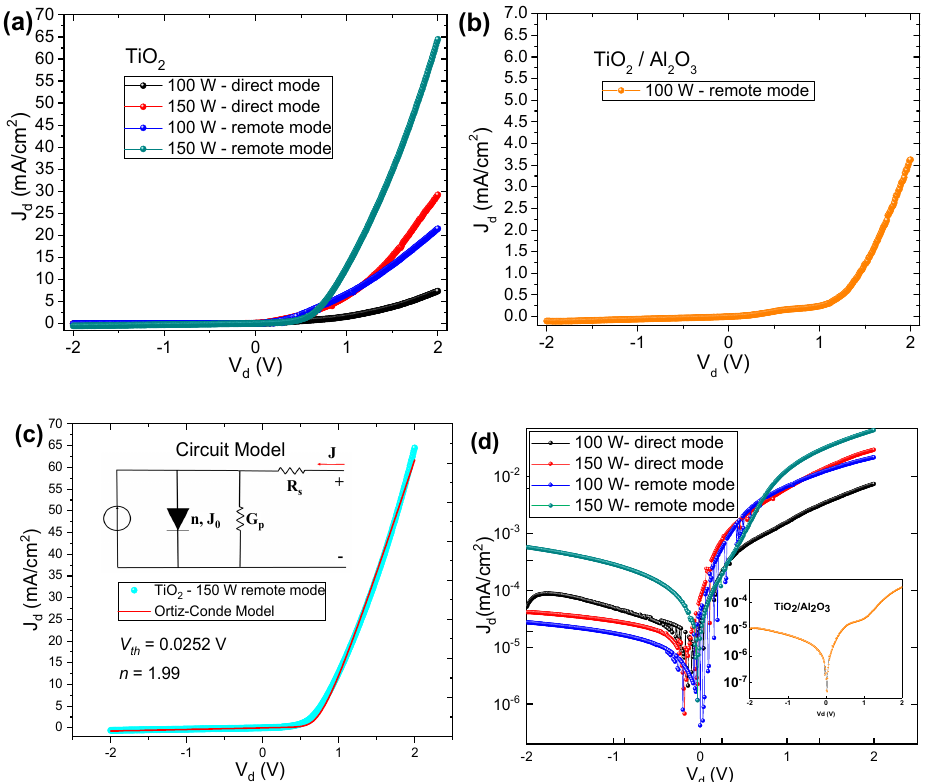
Figure 7. Dark J-V curves for the fabricated MOS capacitors: ( a ) TiO 2 films grown in remote and direct mode at 100 W and 150 W, ( b ) TiO 2 /Al 2 O 3 nanolaminate growth at 100 W, ( c ) adjustment of the curve (TiO 2 -150 W / remote mode) through Ortiz-Conde model [60] and ( d ) dark J-V curves in semi-logarithmic scale, to show the leakage current density. The value of 0.995 was used for the determination coe ffi cient (R-squared) to fit the J-V curve, using the Ortiz-Conde model. That is, 99.5% of the dependent variable was considered, with the error bars in the simulated J-V curves being smaller than the line